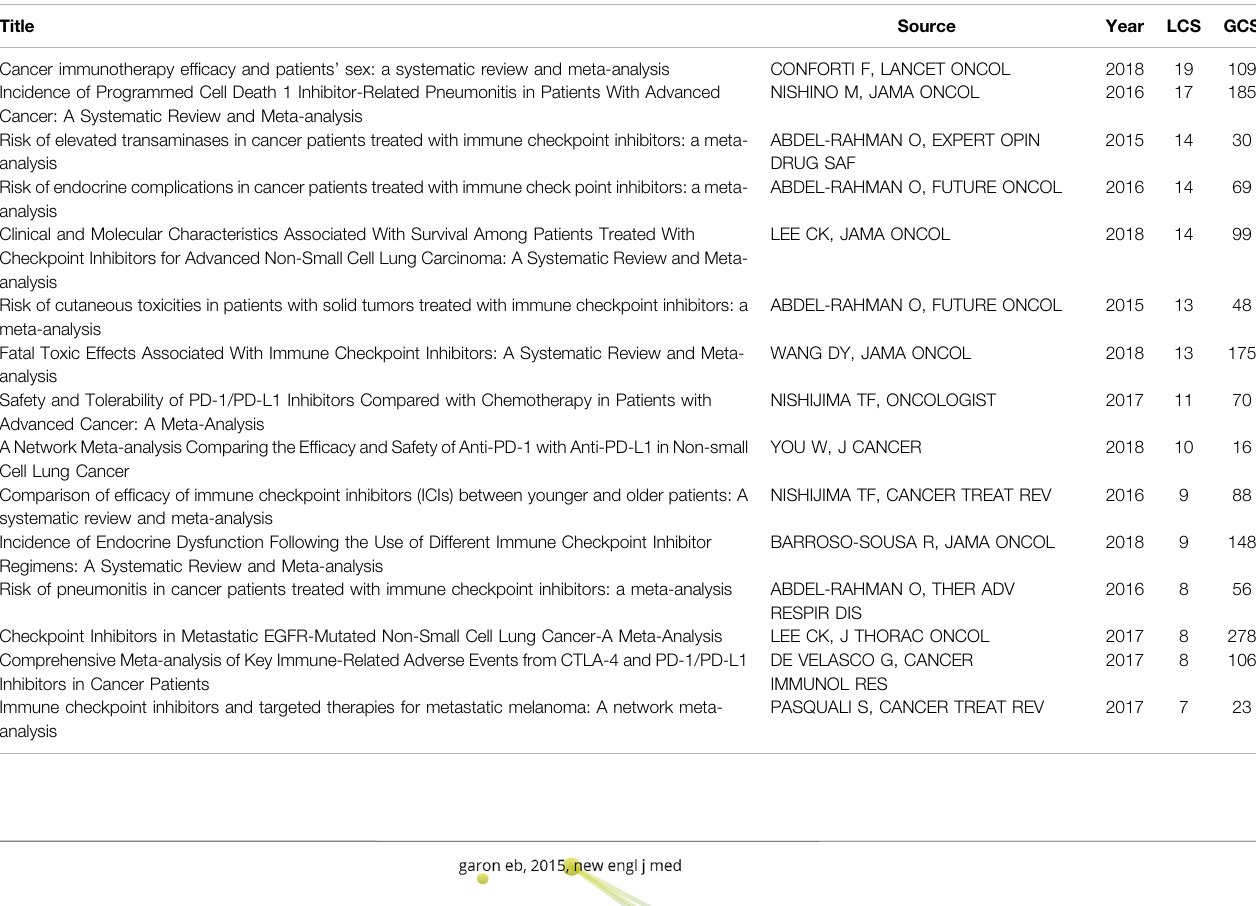
TABLE 5 | Top 15 meta-analysis of anti-PD1/PDL1 sorted by LCS.